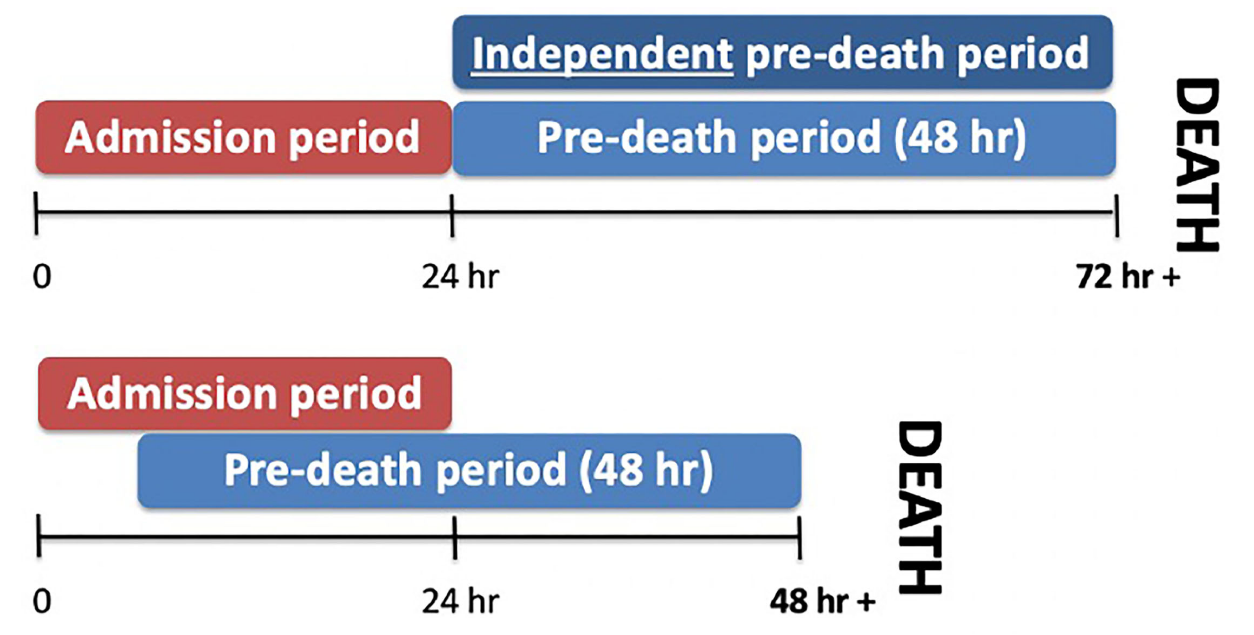
FIGURE 1 | Time period definitions. Three time periods were defined. Admission values were recorded within 24h of admission, while pre-death values were recorded within 48h of death. Non-overlapping pre-death values were defined as independent pre-death